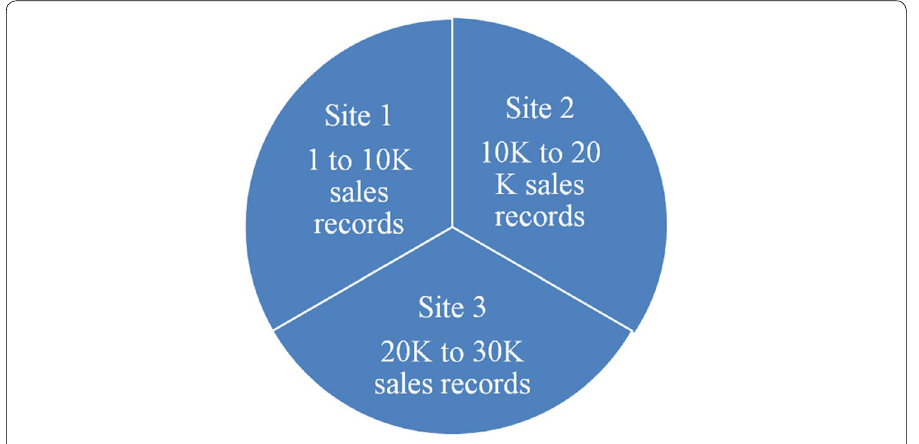
Fig. 1 Distribution of sales data across different